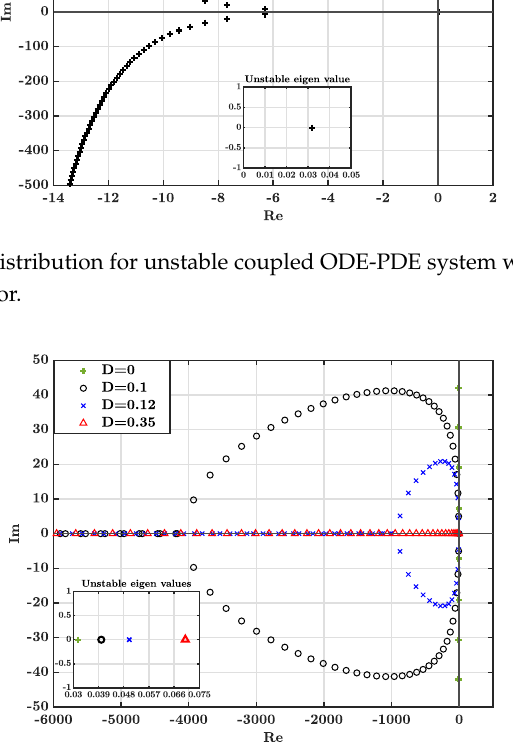
Figure 3. Effects of diffusivity within the dispersive reactor on the eigenvalues placement for unstable coupled ODE-PDE